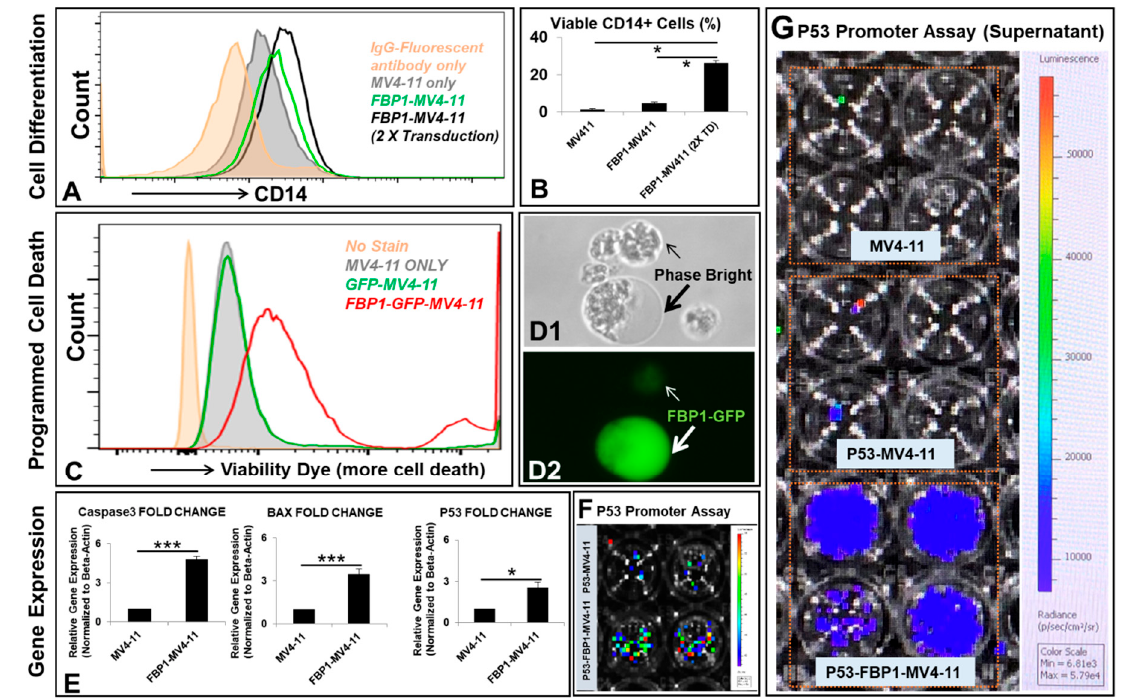
Figure 2. Molecular phenotypes of the FBP1-MV4-11 cell line in vitro: ( A ) A representative FC histogram showing CD14 expression in different MV4-11 cell lines, including naïve MV4-11, FBP1- MV4-11, and FBP1-MV4-11 cells with double FBP1 lentiviral transduction; the histogram of GFP+ expression in these cell lines can be found in Supplementary Figure S1. ( B ) Cumulative FC percentage data of CD14+ cells in different MV4-11 cell lines from ( A ). ( C ) A representative FC histogram showing the expression of viability dye (more expression representing more cell death) in FBP1- MV4-11 (red line plot), GFP-MV4-11 (green line plot), and MV4-11 cells (filled gray plot); the filled orange plot represents the unstained control. ( D1 , D2 ) Representative phase-bright and fluorescent images (20×) showing some GFP+ FBP1-MV4-11 cells that were abnormally larger (indicated by a large arrow) than their neighboring cells; the small arrow indicates a dying cell with weak GFP+. ( E ) Gene expression of programmed cell death proteins in FBP1-MV4-11 cells was analyzed by qPCR; data of mRNA expression show the fold change (normalized to β -actin) of genes encoding caspase-3, BAX, and P53. ( F,G ) P53 promoter assay of blasts and their supernatants was performed (see details in the Materials and Methods); representative live images show luciferase activity in MV4-11 and FBP1-MV4-11 blasts ( F ) and supernatants from different experimental groups ( G ). Where applicable, data are means ± SEM and were analyzed by Student’s “ t ”-test; * p < 0.05, *** p < 0.005, n = 3.